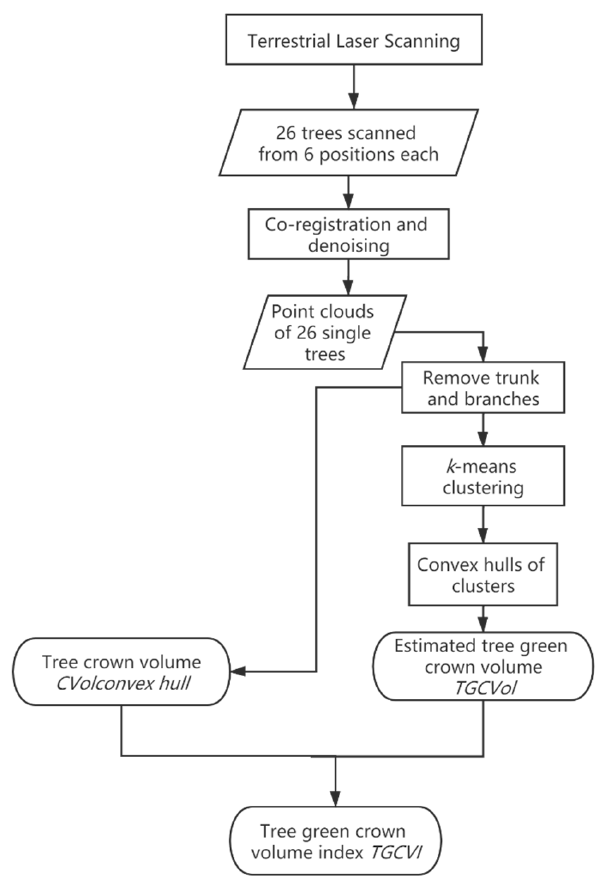
Figure 3. Schematic workflow.